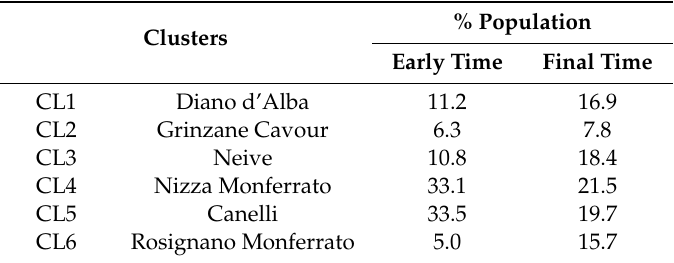
Table 10. Determination of scenarios changing the weights of landscape indicators.